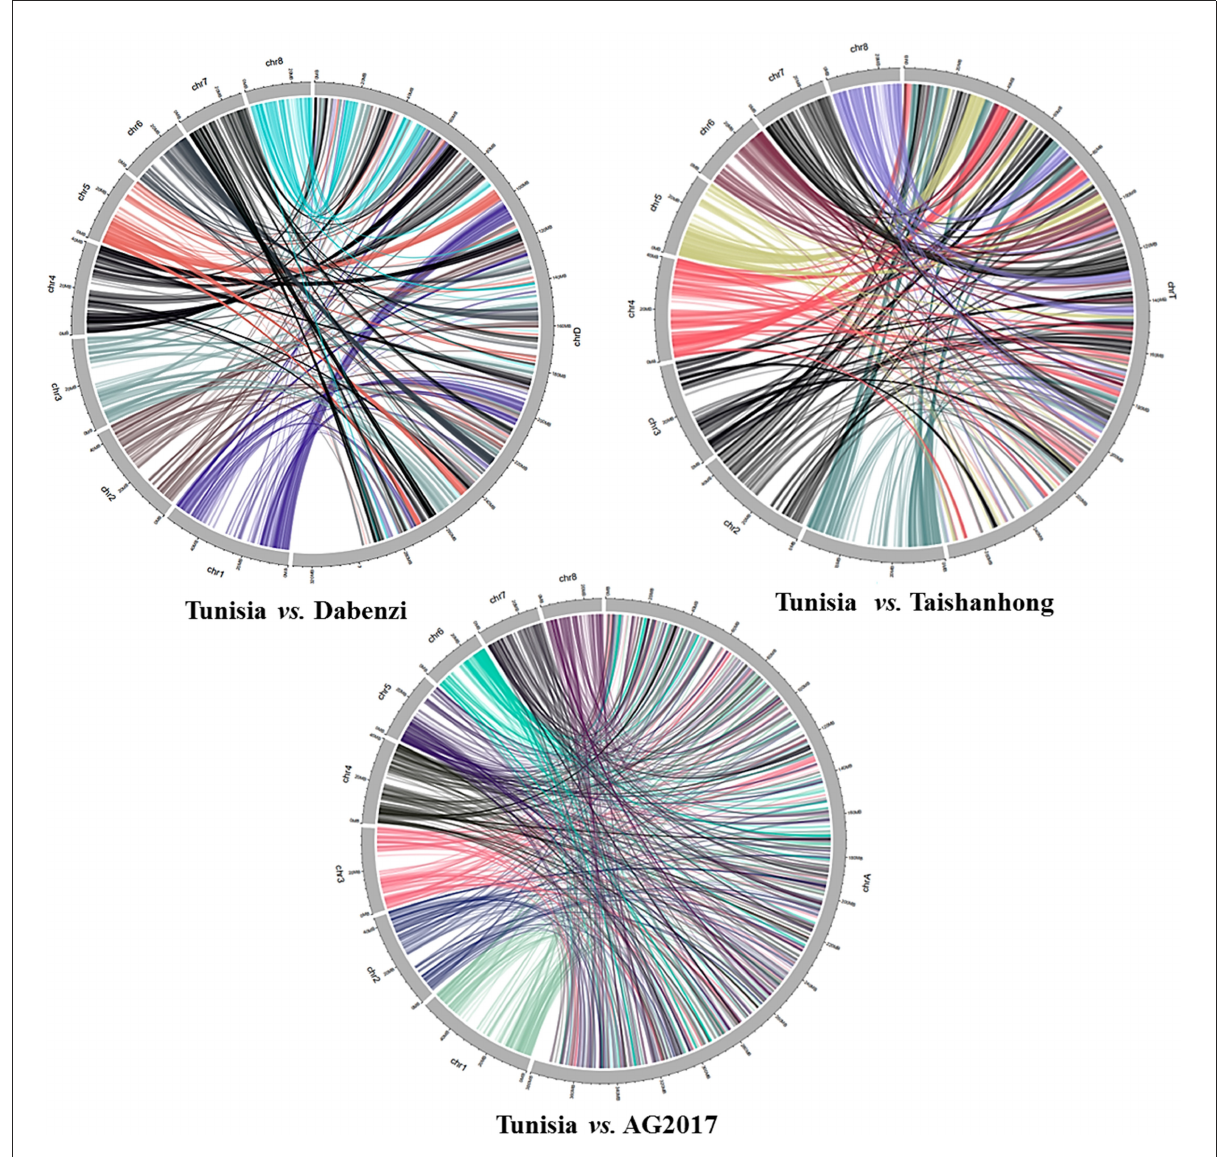
FIGURE5 Syntenic relationships between Tunisia in comparison to Dabenzi, Taishanhong and AG2017 genomes based on 1233 PIP markers.